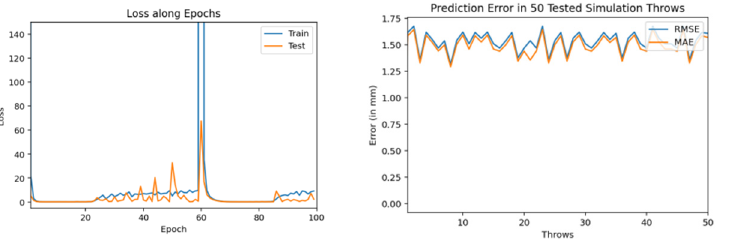
Figure 15. Training and testing results by encoder-decoder bidirectional LSTM deep NN (trained through 3000 throws with 100 epochs and 100 neurons).